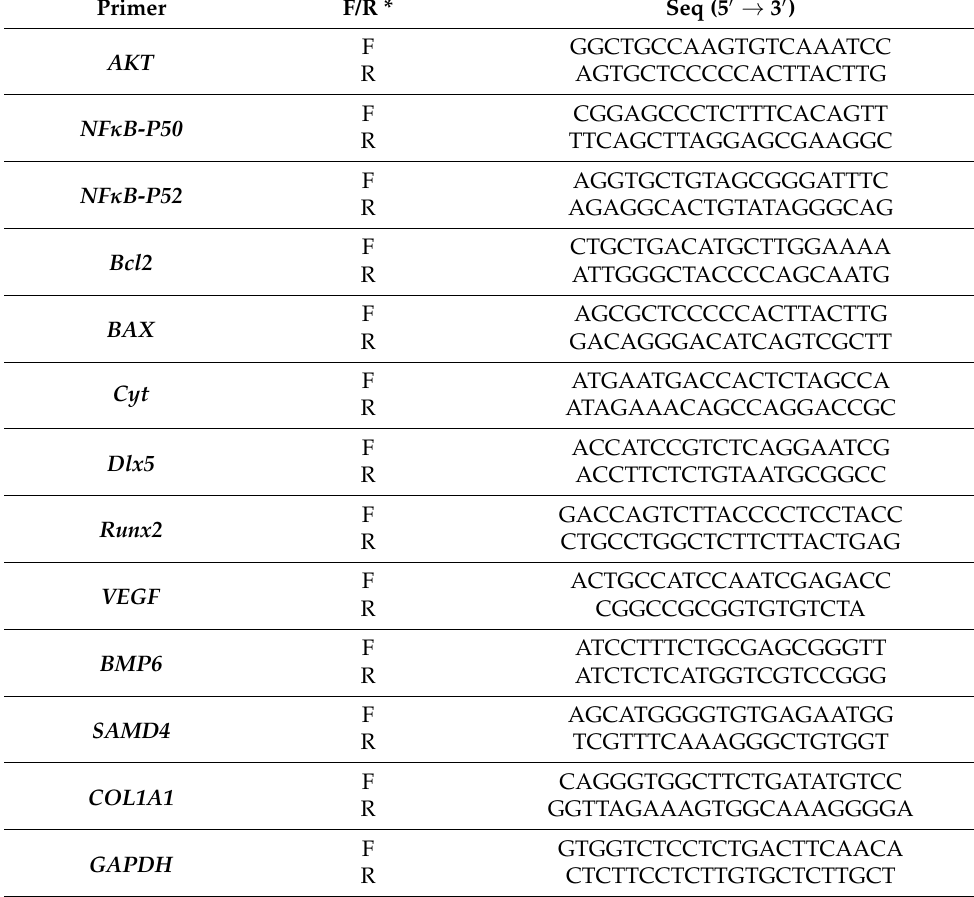
Figure 1. A schematic flow chart for the research procedures. ASC: adipose-derived stem cell. Table 1. The list of primers for